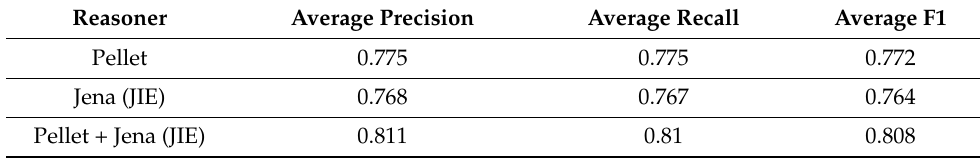
Table 3. Predicted roles evaluation (average values for precision, recall and